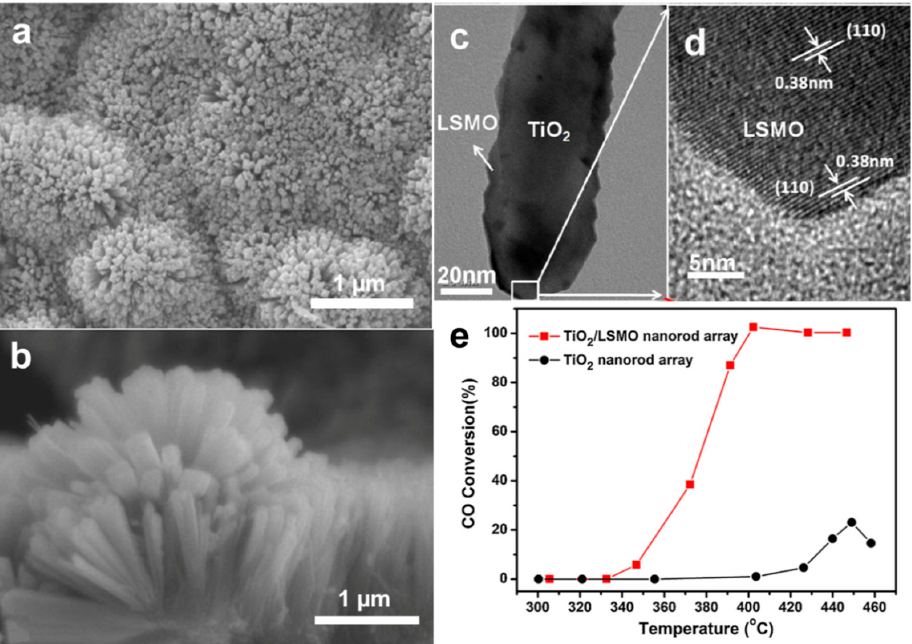
Figure 11. ( a ) A top view and ( b ) SEM cross ‐ sectional view image of TiO 2 /LSMO nanorod arrays on Si substrates; ( c ) Bright field and ( d ) HRTEM images of a typical TiO 2 /LSMO core ‐ shell nanorod after 800 °C annealing; ( e ) Catalytic CO oxidation performance of TiO 2 /LSMO core ‐ shell nanorod arrays and TiO 2 nanorod arrays. Reprinted with permission from [26], Copyright Elsevier, 2012.